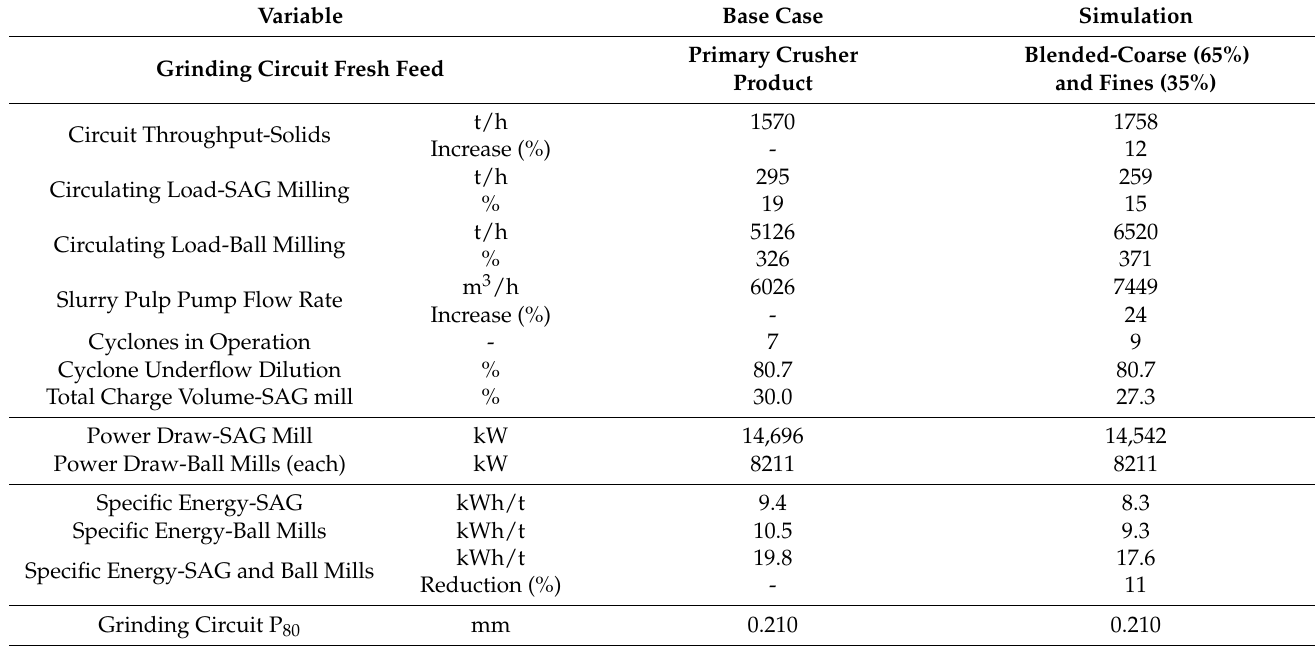
Table 4. Summary of grinding circuit